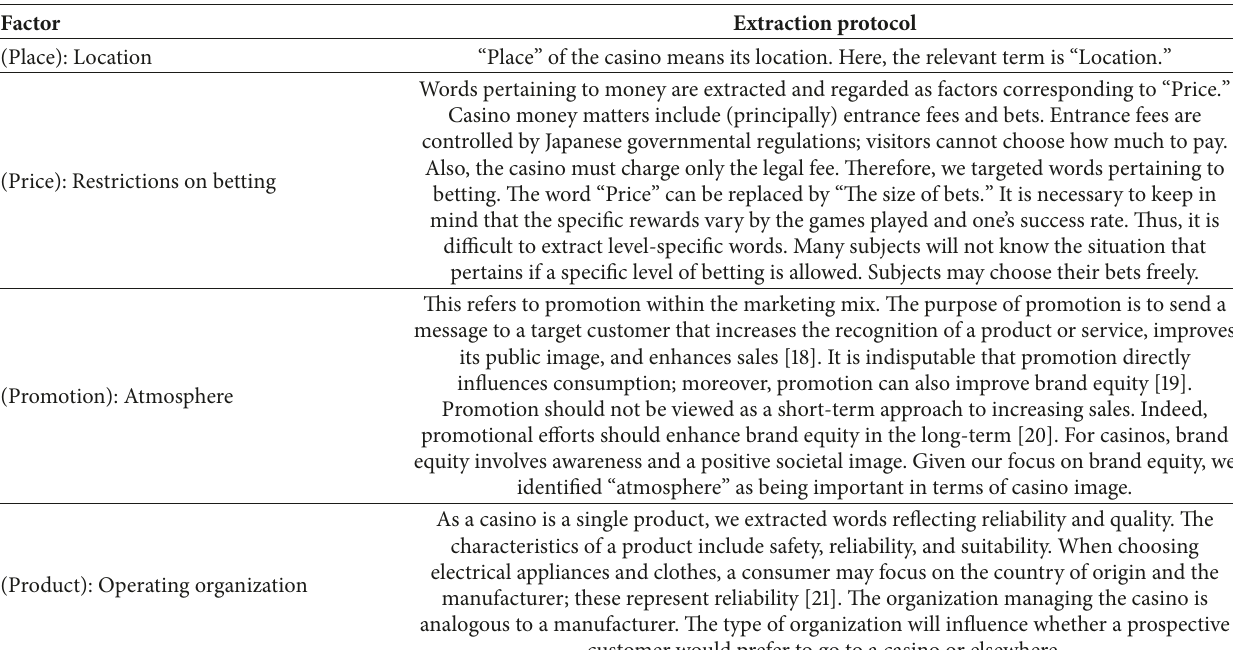
Table 1: Extraction of words expressing factors based on the four Ps.